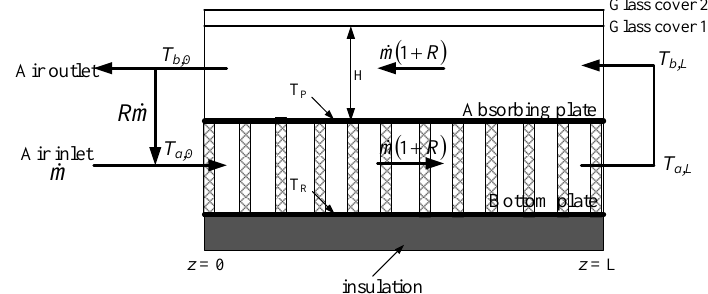
Figure 1. A schematic drawing of a wire mesh packed double-pass solar air